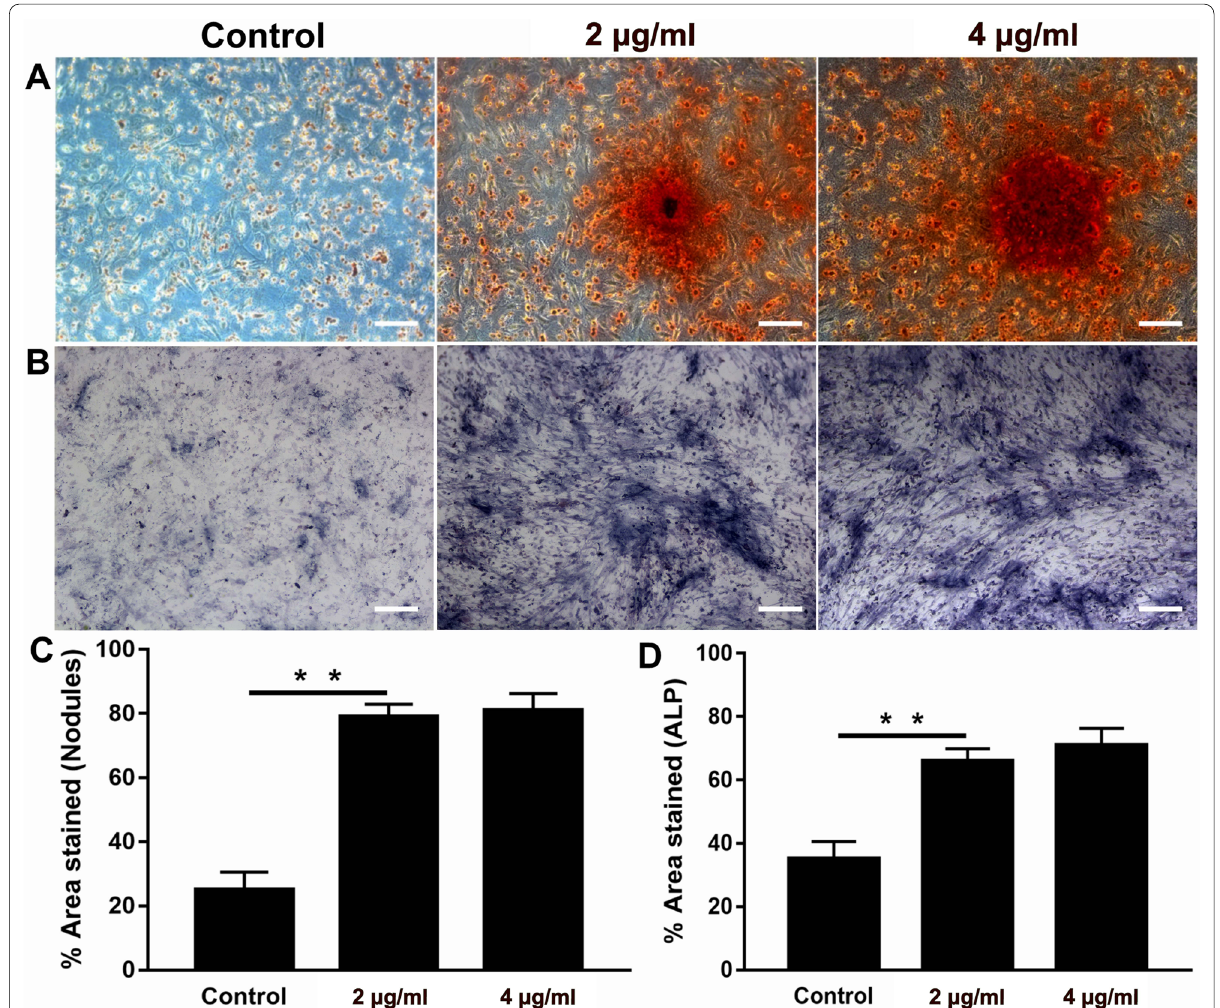
Fig. 5 Alkaline phosphatase (ALP) and Alizarin Red staining assays. A Osteogenic-differentiated EMSCs stained with Alizarin Red solution at day 14; B ALP staining was visualized under microscope; C the chart shows the quantification of Alizarin red deposition areas; D significantly higher ALP activity was shown in the BP-treated EMSCs group than that of the control group. Data were expressed as the mean